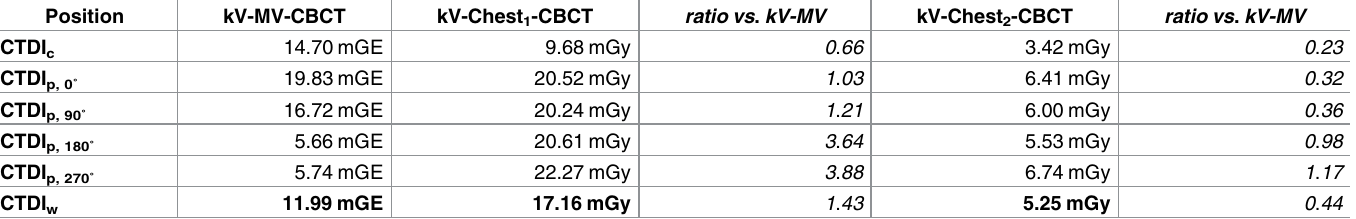
Table 4. Determination of weighted CTDI for different CBCT-presets (GE: Gray-equivalent with RBE = 2 for kV-dose contribution) (columns 2, 3 and 5) and ratio between the imaging methods and reference dose output kV-MV (D/D ref ) (columns 4 and 6). Position